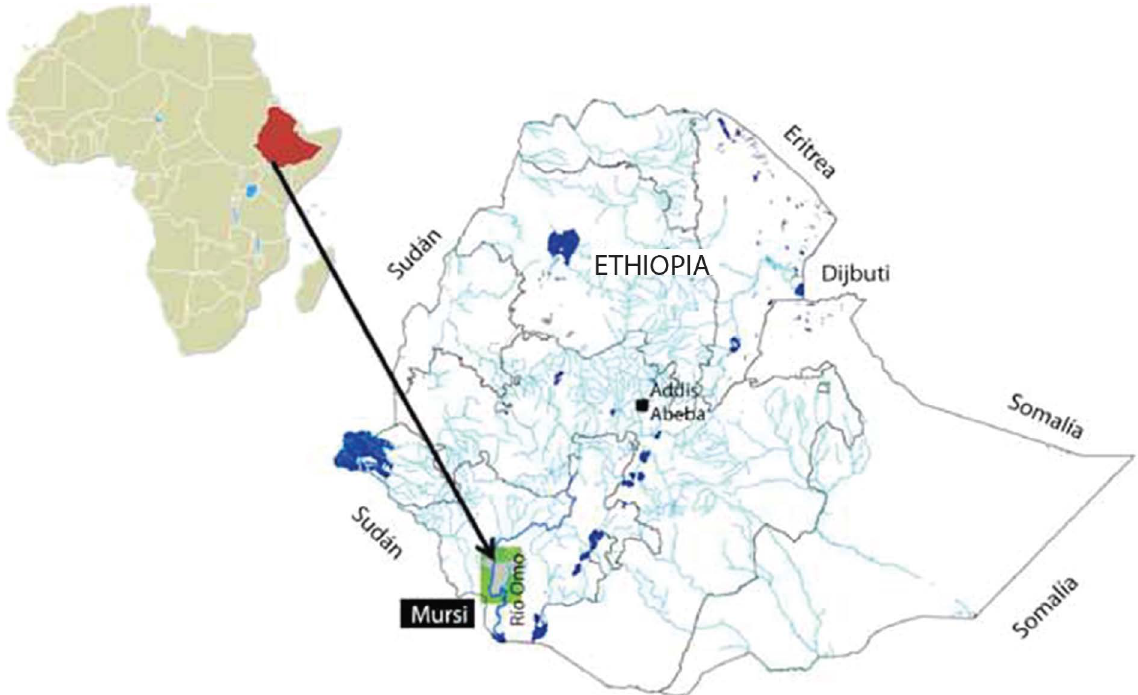
Figure 1. Localisation of the Mursi area in the Omo Valley (after Salazar et al. 2012: 381). The main crop is sorghum ( Sorghum Bicolor (Linn.) Moench ) (of which the Mursi